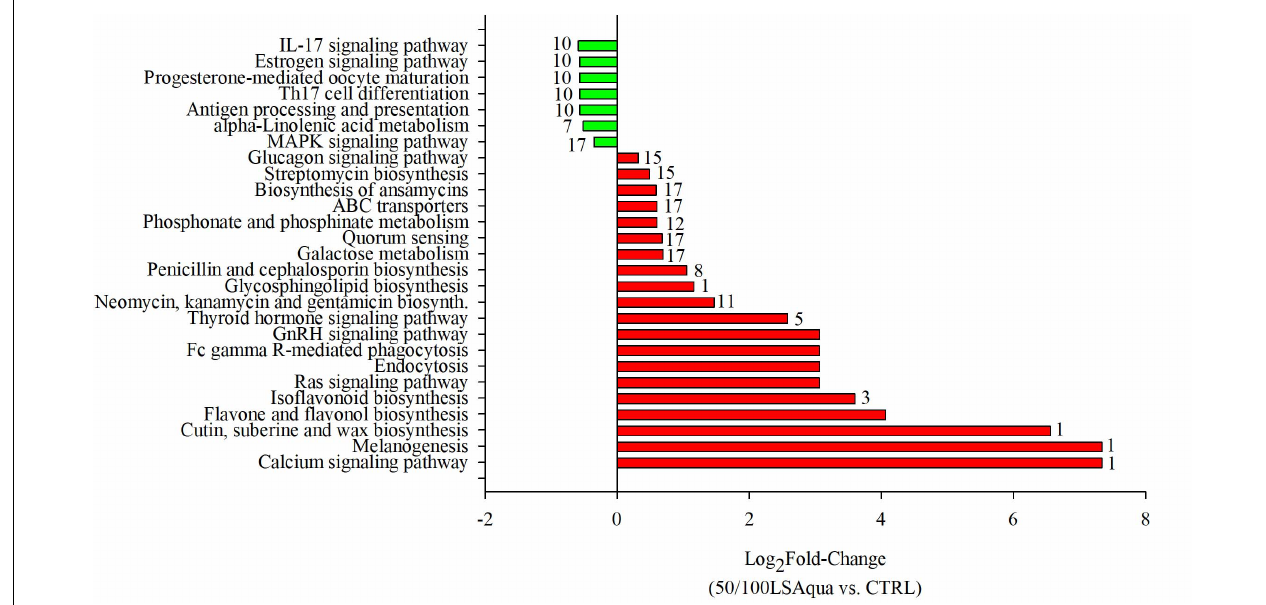
FIGURE 7 | Pathway analysis from predicted metagenome. Values represent the Log 2 fold change of the comparison between 50/100LSAqua vs. CTRL groups (FDR < 0.05). Numbers in bars indicate the number of abundant OTUs (VIP > 1; > 1%) related with the expression of genes involved in each